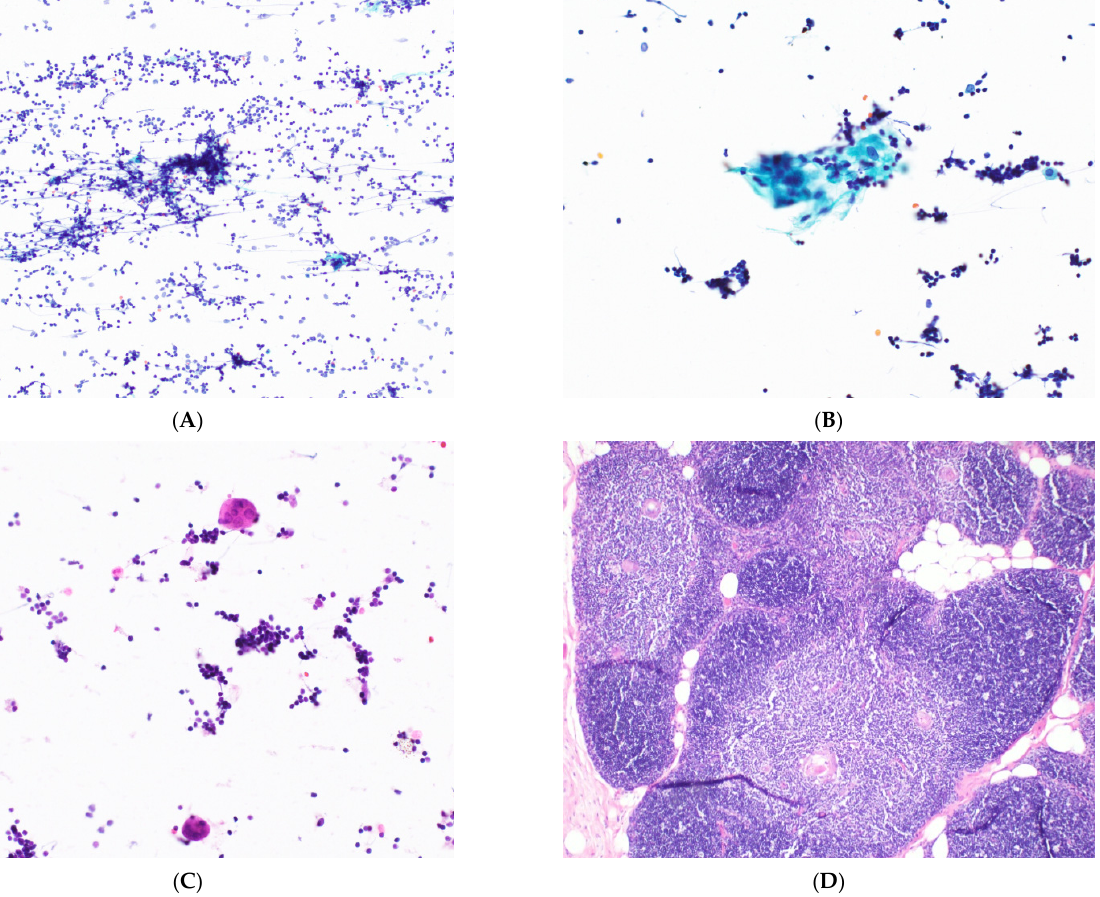
Figure 2. Thymic hyperplasia. ( A ) Low-power view of a thymic smear with small clusters of lymphoid and epithelial cells on a background of lymphocytes. H&E stain, 10 × objective. The epithelial cell clusters can mimic lymphoid tangles in lymph node aspirates. They are typically smaller and sparser than those seen in thymoma. ( B , C ) The squamoid cells of Hassall’s corpuscles are rarely seen in aspirates, but when present they favor a diagnosis of thymic hyperplasia over thymoma. Pap and H&E stains, 40 × objectives. ( D ) Resection specimen showing thymic hyperplasia, characterized by lymphoid follicles, Hassall’s corpuscles, and retained lobular thymic architecture. H&E stain, 10 ×